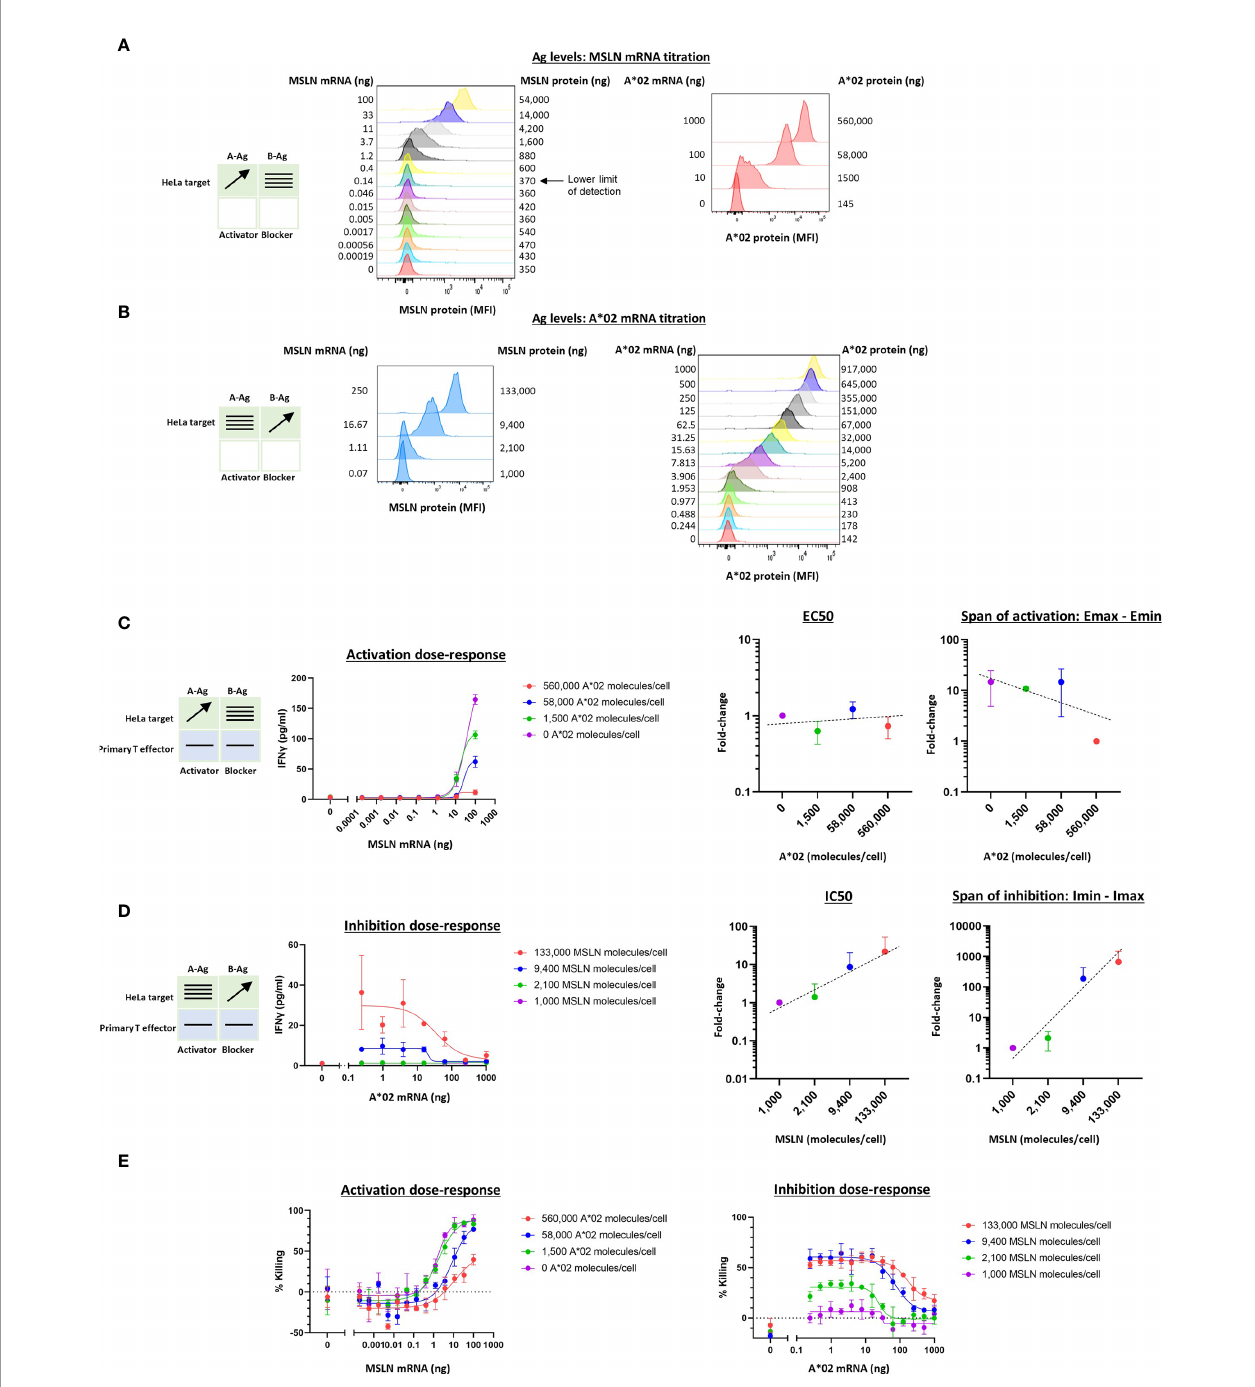
FIGURE 4 | Two-dimensional target Ag (MSLN and A*02) mRNA titration in HeLa [A*02(-)MSLN(-)] target cells with primary T cell effectors. Target cells were a HeLa variant with MSLN knocked out and GFP introduced via transduction (see Methods ). (A) MSLN (A-Ag) titration and surface expression visualized by fl ow cytometry. (B) A*02 (B-Ag) titration. (C) Dose-response of MSLN and A*02 target Ag variation with constant activator/blocker ratio on primary T effector cells. MSLN A-Ag titrated with varying A*02 B-Ag levels held constant (EC50 and Emax vs B-Ag levels). IFN g release was measured after 24 hours of co-culture. Fold-change is calculated by normalizing to the lowest value. (D) A*02 B-Ag titrated with varying MSLN A-Ag levels held constant (IC50 and Imax vs. A-Ag levels). IFN g release was measured after 24 hours of co-culture. Fold-change is calculated by normalizing to the lowest A-Ag value. (E) Acute killing of GFP-labeled target cells after 12 hours of co-culture. Dashed lines are meant to convey trends and are not fi t